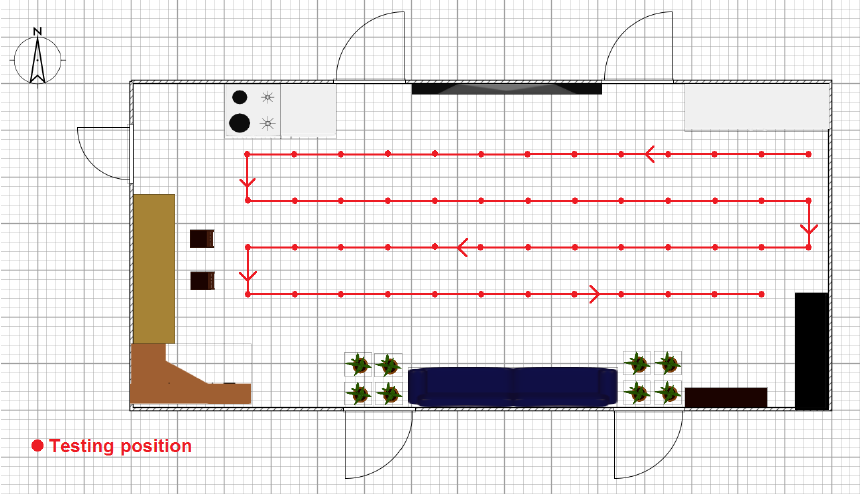
Figure 6. Illustration of the moving trace of the automatic calibration equipment.